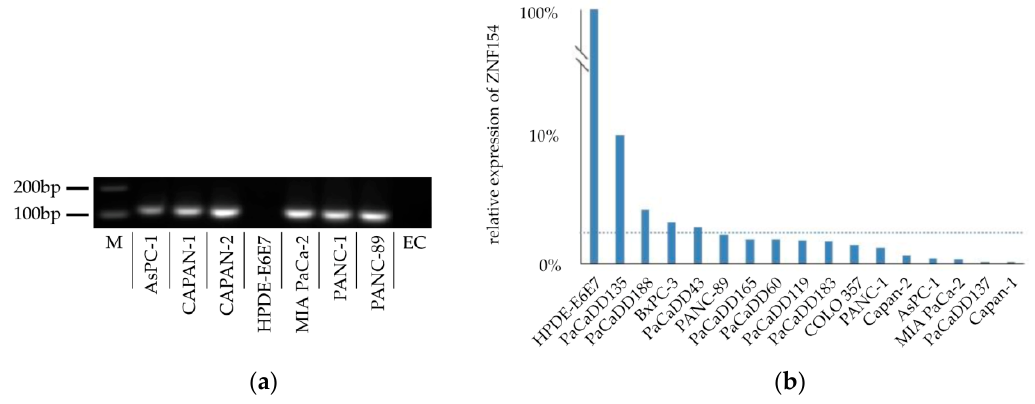
Figure 1. ( a ) Exemplary image of PCR gel electrophoresis checking ZNF154 hypermethylation in di ff erent cell lines (AsPC-1 cells, CAPAN-1 cells, CAPAN-2 cells, HPDE-E6E7 cells, MIA PaCa-2 cells, PANC-1 cells, TM3M4 cells; M = marker at 200 and 100 bp, EC = empty control). ( b ) Relative expression levels of RNA coding for ZNF154 found in di ff erent cell lines compared to that in HPDE-E6E7 cells (dotted line = mean relative expression of